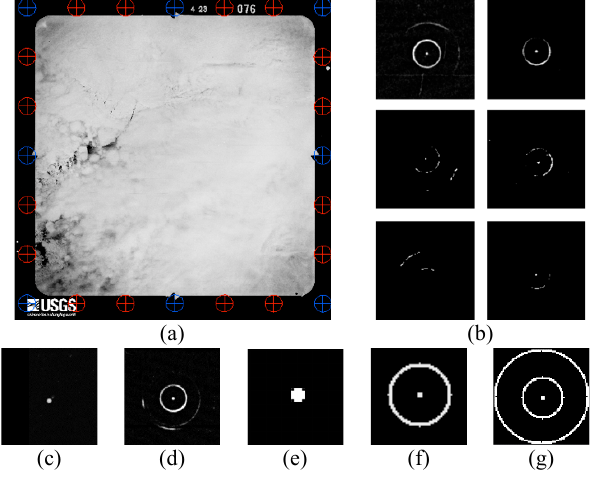
Figure 1. (a) Distribution of FMs on ARGON 9059A image; (b) - (d) FMs of various levels of quality; and (e)-(g) three types of FM